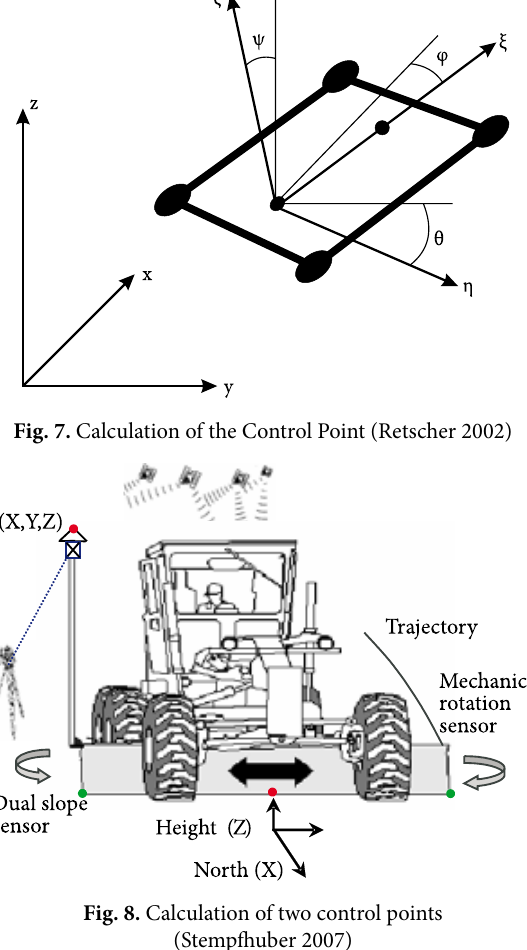
Fig. 8. Calculation of two control points (Stempfhuber 2007)